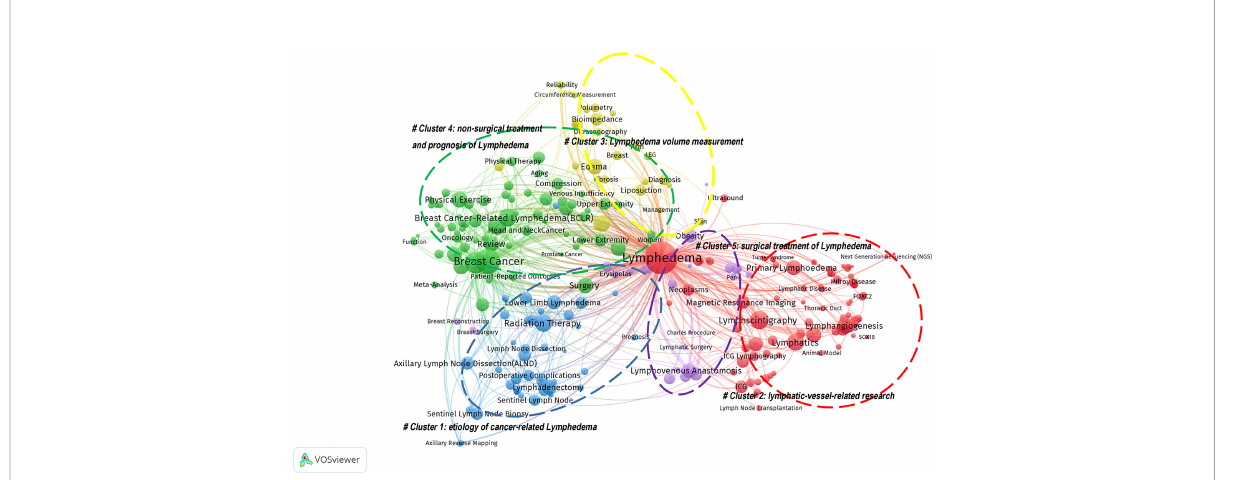
FIGURE 8 The cluster network based on Lymphedema high-frequency keywords ( ≥ 10 times). Cluster1 (Blue circle): research on the etiology of cancer- related Lymphedema; Cluster 2 (Red circle): lymphatic-vessel-related research, including the main terms of lymphangiogenesis and lymphatic system imaging; Cluster 3 (Yellow circle): Lymphedema volume measurement; Clusters 4 (Green circle): research on non-surgical treatment and prognosis of Lymphedema; and Clusters 5 (Purple circle): studies on the surgical treatment of